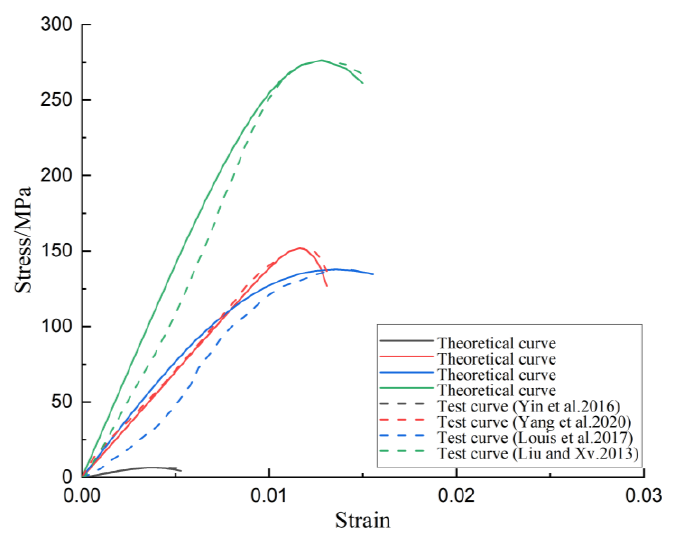
Figure 5. Comparison of experimental results in literature and theoretical curves [55–58].